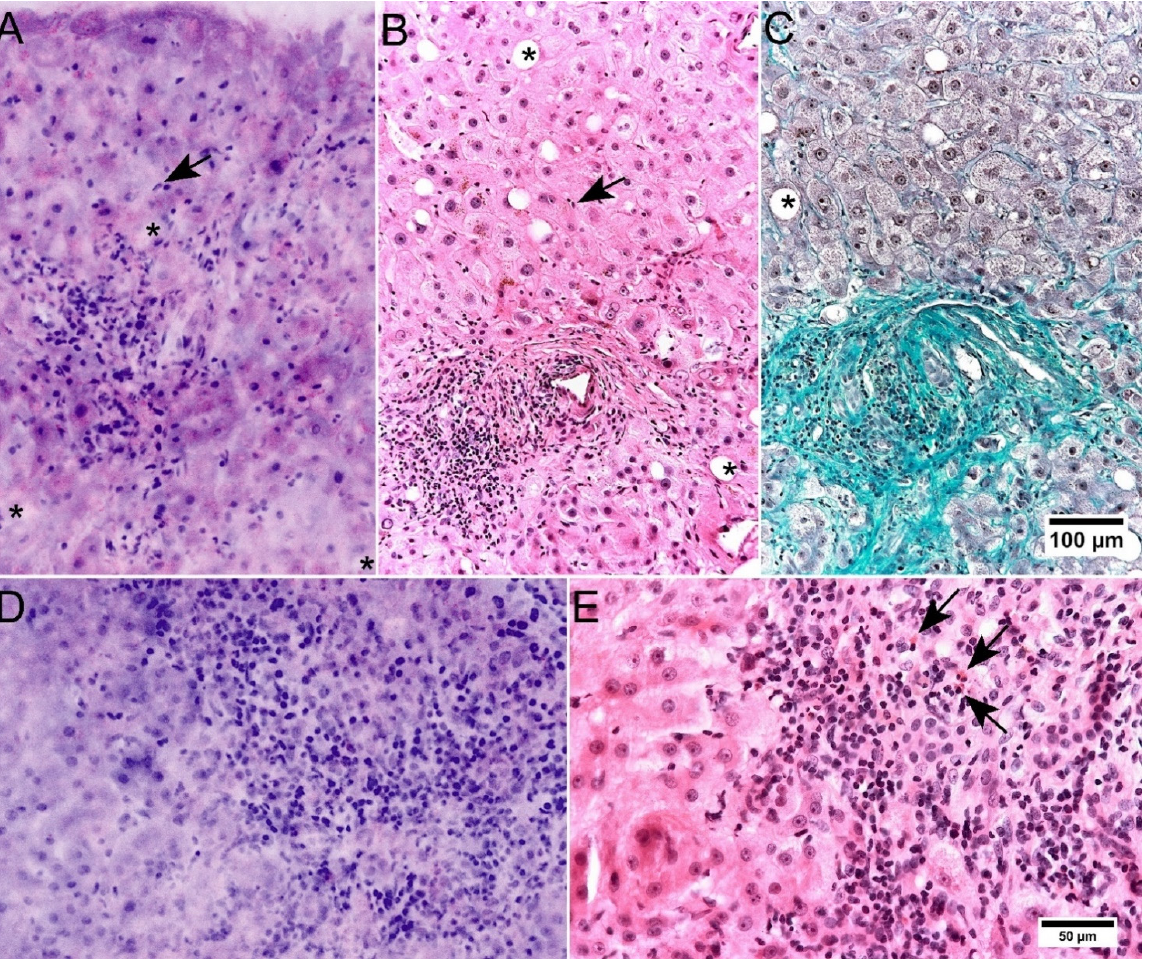
Figure 5. Representation of inflammatory changes in FCM scans. ( A – C ): Liver biopsy of a case with methotrexate induced liver injury in FCM ( A ) and conventional histology (( B ), HE staining) with special stains (( C ), Masson’s trichrome). Portal and interface inflammation are well represented in FCM. Stellate cell hyperplasia (arrows) can be recognized in FCM comparable to conventional histology. Fatty vacuoles (asterisks) are more difficult to recognize in FCM. Fibrotic fibers are not represented in FCM and HE stain, the real amount of fibrosis is only recognized in Masson’s trichrome staining. ( D , E ): Liver biopsy of a case with drug induced liver injury in FCM ( D ) and conventional histology (( E ), HE staining). Portal and periportal inflammatory infiltrates are shown in a comparable way. Note the missing representation of eosinophilic granules in the FCM scans (arrows).